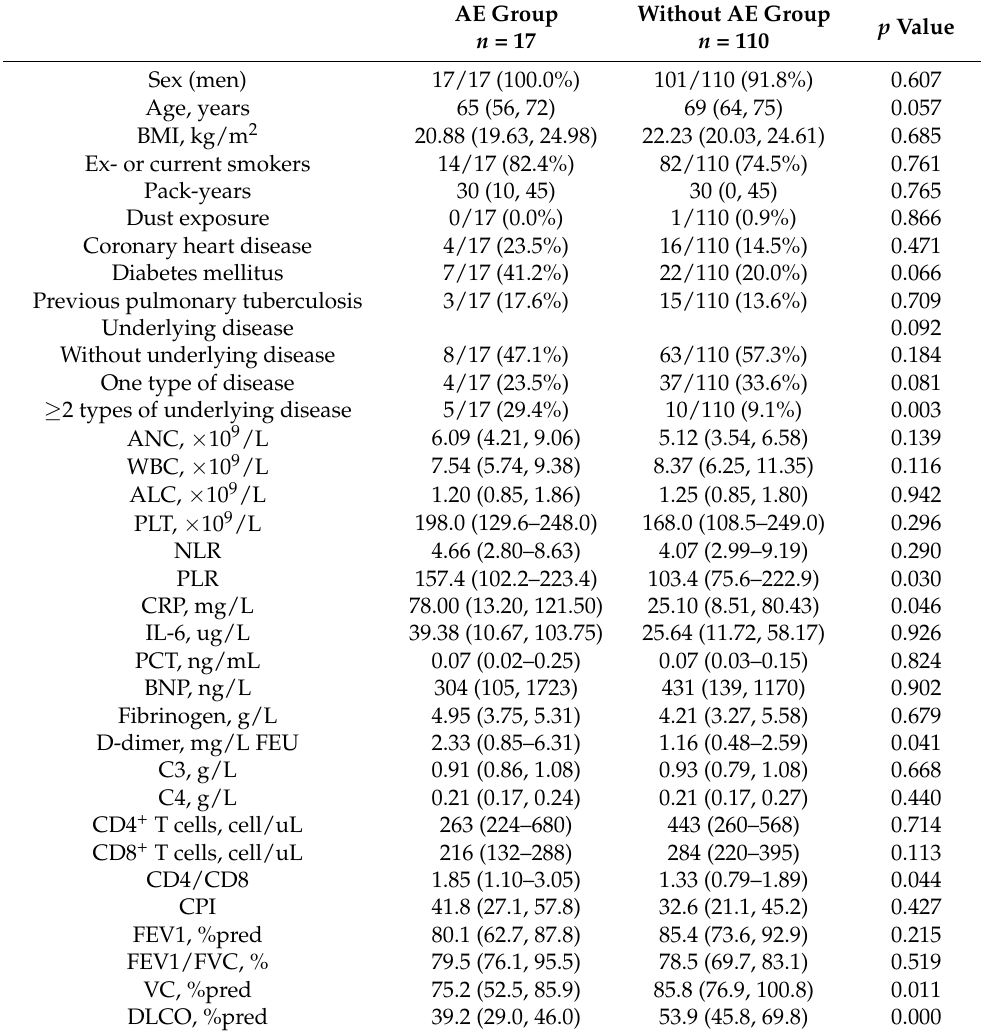
Table 5. Comparisons between CPFE patients with AE and without